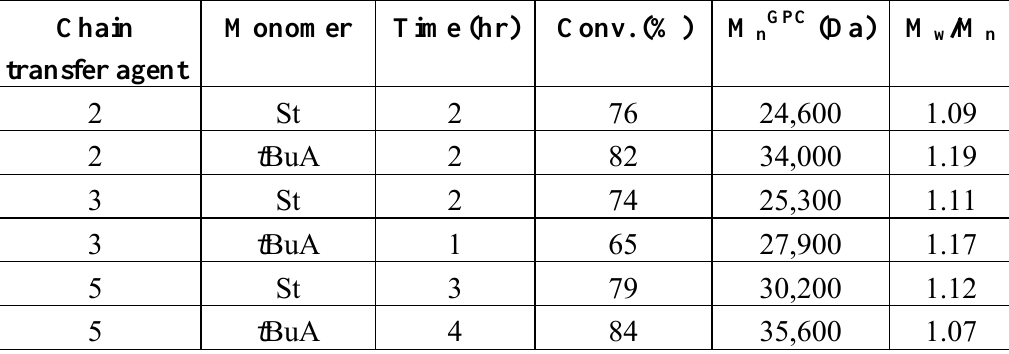
Table 1. Polymerization data for the dual functional chain transfer